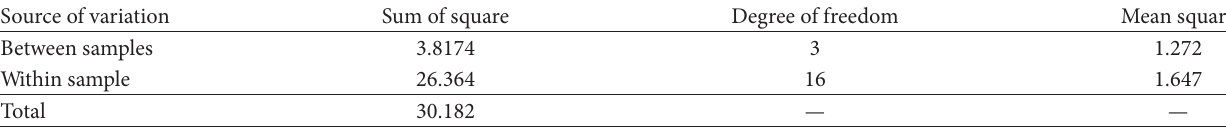
T 7: ANOVA table of comparison of results of reported spectrophotometric and proposed baseline manipulation methods for TE. Source of